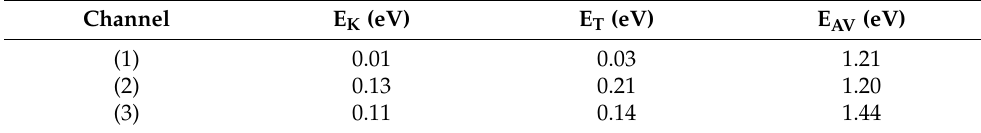
Table 2. The energy list for above estimated channels.